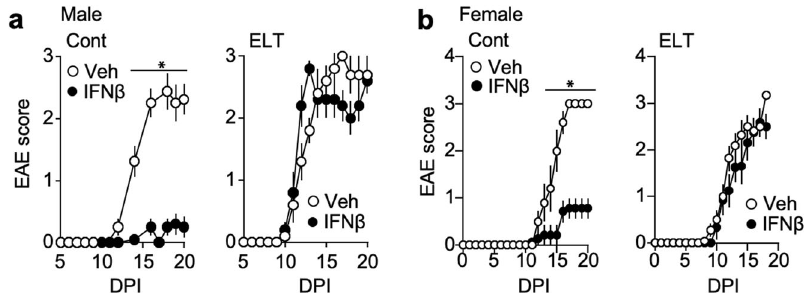
Fig. 4 ELT-EAE mice are interferon- β resistant. a , b Mean clinical EAE scores of control EAE and ELT-EAE male ( a ) and female ( b ) mice with or without interferon β (IFN β ) treatment (Male Cont-Vehicle: n = 8, Male Cont-IFN β : n = 10, Male ELT-Vehicle: n = 5, Male ELT-IFN β : n = 5, Female Cont-Vehicle: n = 5, Female Cont-IFN β : n = 7, Female ELT-Vehicle: n = 5, Female ELT-IFN β : n = 5). Interferon- β was treated from 0 to 10 dpi every other day. All data represent mean ± SEM. Two-tailed Student ’ s t -test, * P < 0.05. Exact P values for asterisks are derived from AUC (from left to right): a <0.0001, b <0.0001.